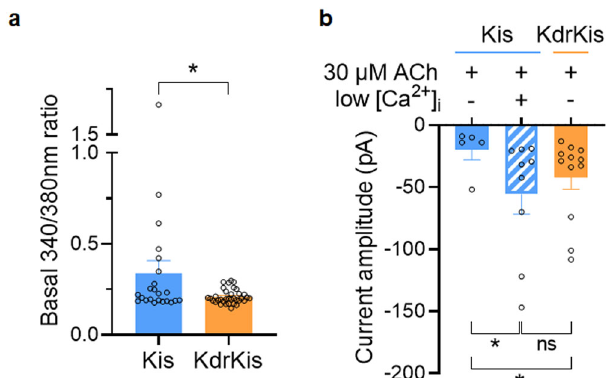
Fig. 8 Lowering intracellular calcium concentration in Kis neuron cell body mimicks the ACh-induced current amplitude recorded in KdrKis neurons. a Comparative histogram illustrating the steady-state resting intracellular calcium level (expressed as ratio 340/380 nm) measured in Fura-2-loaded Kis ( n = 11) and KdrKis ( n = 36) neuron cell bodies. Bars represent mean ± S.E.M. Statistical test used was the Mann – Whitney test, * p < 0.05. b Comparative histogram illustrating the effect of the internal pipette solution containing low intracellular calcium concentration (0.01 µ M) on the ACh-induced current ( n = 9) amplitude in Kis neurons ( n = 5) compared to KdrKis ( n = 9) and Kis neurons in control conditions. Note that lowering intracellular calcium concentration increases the ACh-induced current amplitude in Kis neurons, an amplitude, which is very close to that of recorded in KdrKis neurons in control. Bars represent mean ± S.E.M. Statistical test used was the Mann – Whitney test, * p < 0.05, ns, non-signi fi cant. In all cases, the number of experiments ( n ) are biologically independent